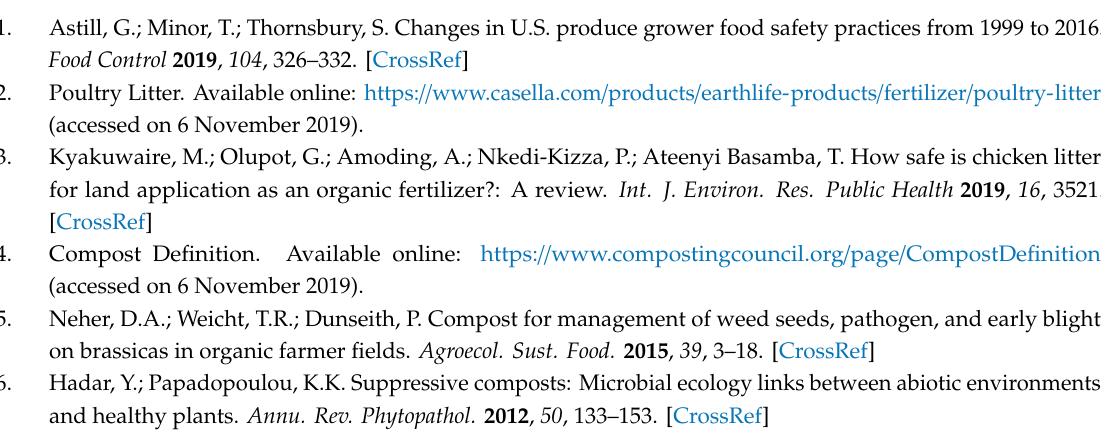
Table S1: Enzymes tested and associated soil substrates, experimental substrates, and positive controls [16], Table S2: Candidate taxa were those that emerged after filtering PCR results for both fields combined and each field separately for each the 16S amplicon genes. Taxa highlighted in yellow are those chosen for representation in Table 4; Table S3: Median percentage of sequences of the most abundant classified bacteria by compost treatment, Table S4: Median percentage of sequences of the most abundant classified fungi by compost